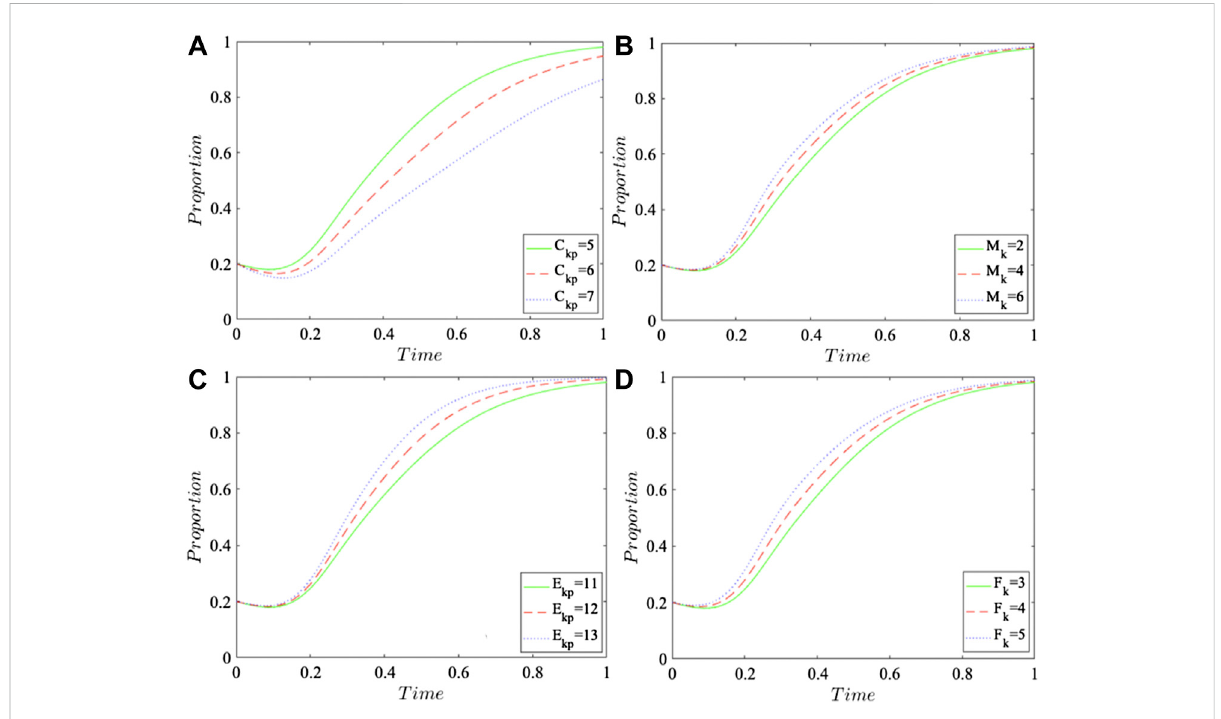
FIGURE 8 In fl uenceofchangingparametersonthird-partyrecyclingenterprises. (A) Impactofchangesincollaborationcosts, (B) impactofchangesinthe amount of reward, (C) impact of changes in pro fi ts in increase pro fi ts, (D) impact of changes in the amount of